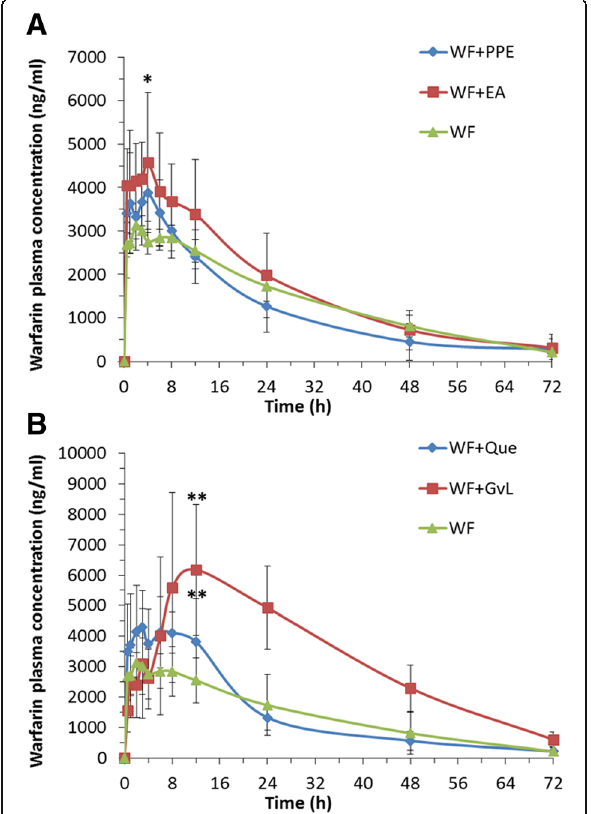
Fig. 2 In vivo plasma concentrations of warfarin versus time curves in rats after a single oral dose of 0.5 mg/kg warfarin, along with warfarin in combination with: ( a ) five doses of pomegranate peel extract (100 mg/kg) and ellagic acid (40 mg/kg), ( b ) five doses of guava leaves extract (250 mg/kg) and quercetin (12.75 mg/kg). Each data point represents the mean ± SEM ( n = 8). *p < 0.05, **p <